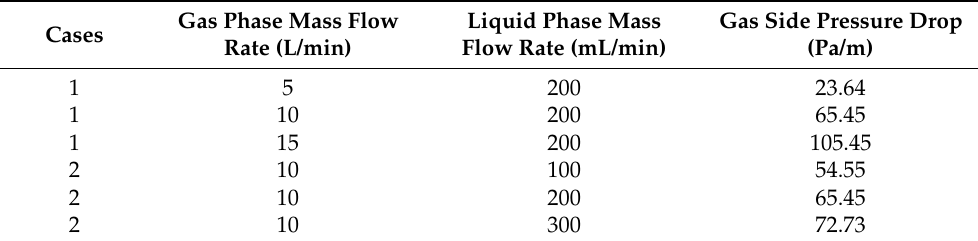
Table 2. Experimental matrix and gas side pressure